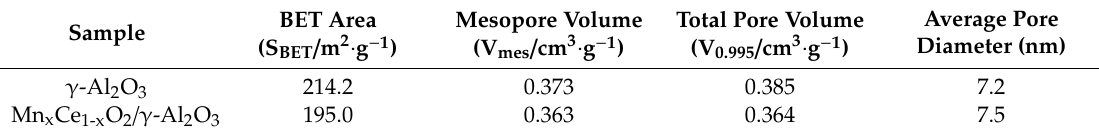
Table 2. Physico-chemical properties of the support and catalyst.